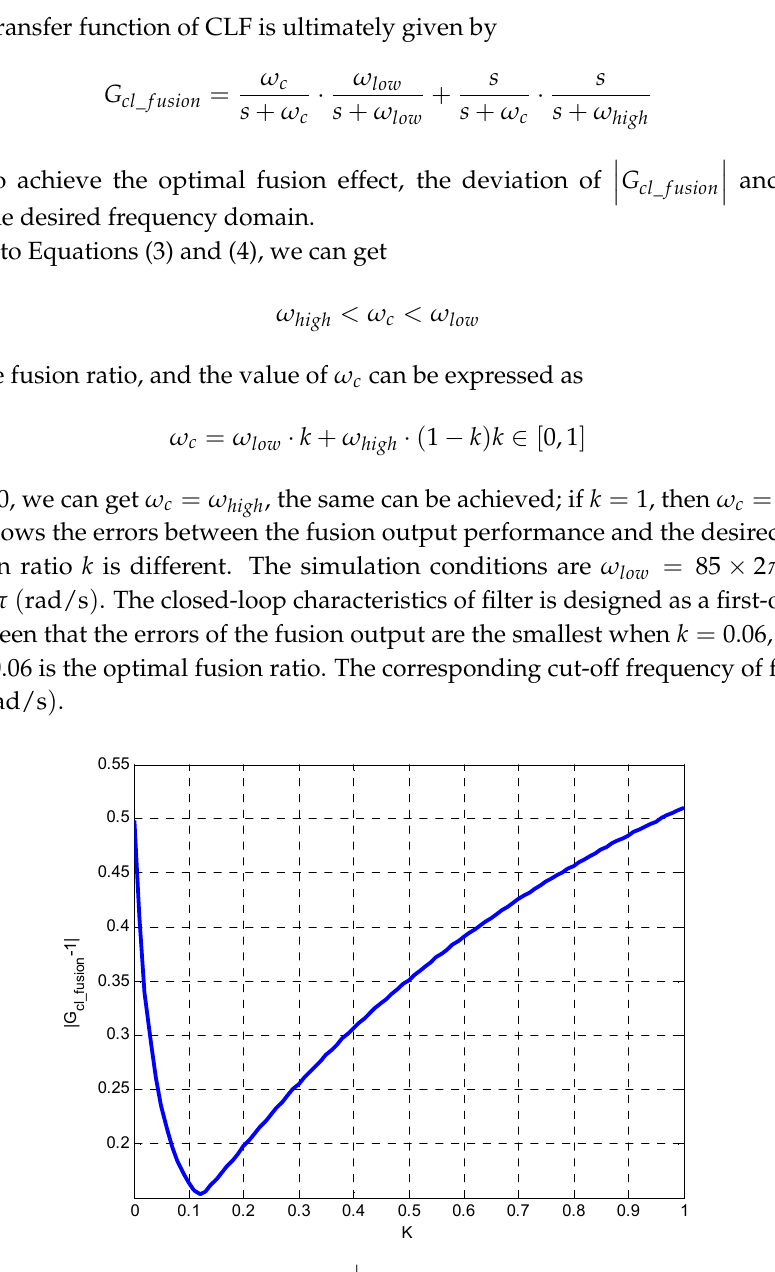
Figure 5. The fusion error of